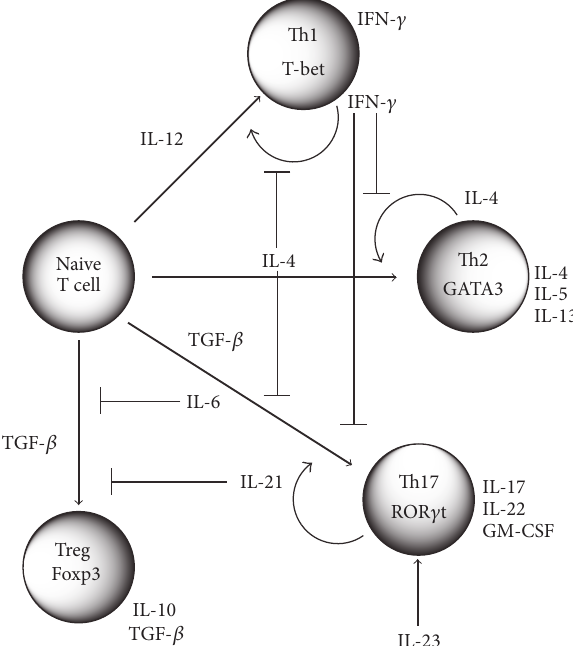
Figure 1: Regulation of Th cell differentiation. Na¨ıve CD4 T cells differentiate into four distinct T cell subsets such as Th1, Th2, Th17, and induced T regulatory (Treg) cells dependent on the cytokine